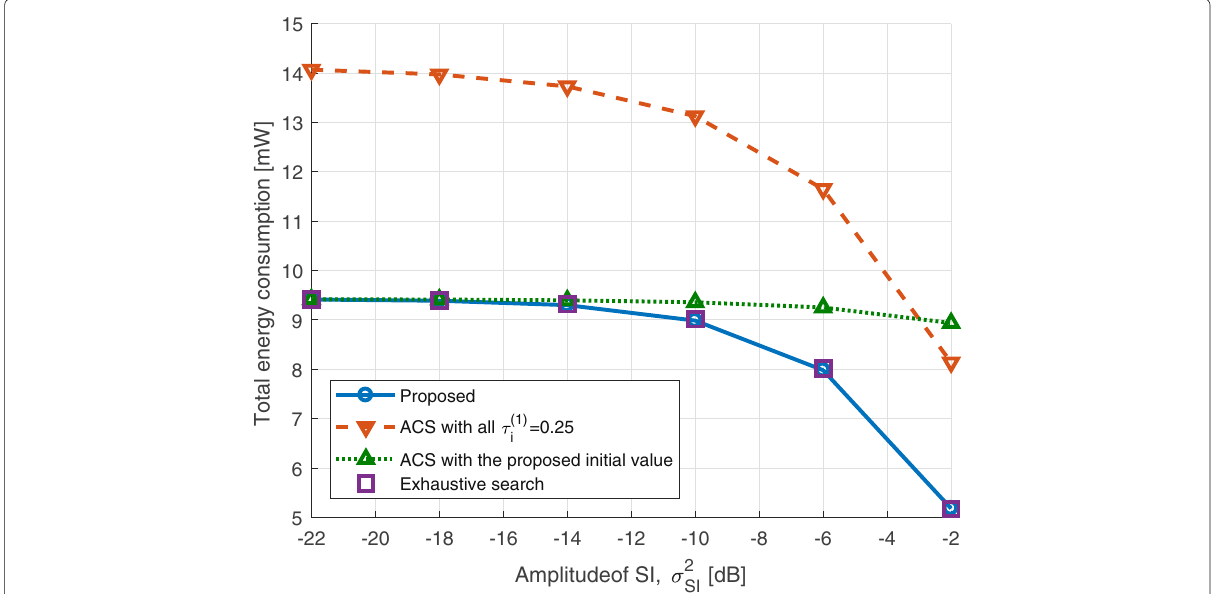
Fig. 2 Convergence of the proposed scheme compared to ACS. C 1 = C 2 = 1[bps / Hz], D =